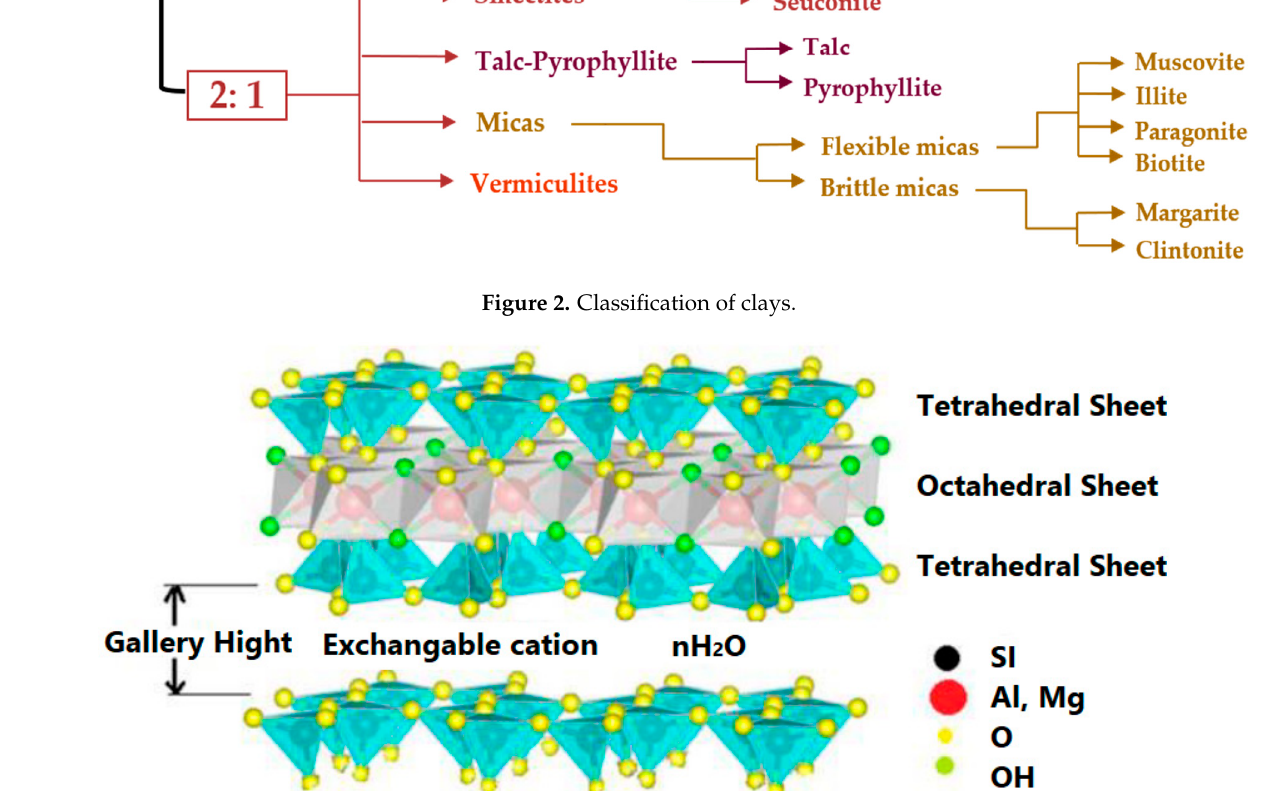
Figure 3. Structure of 2:1 layered silicate.